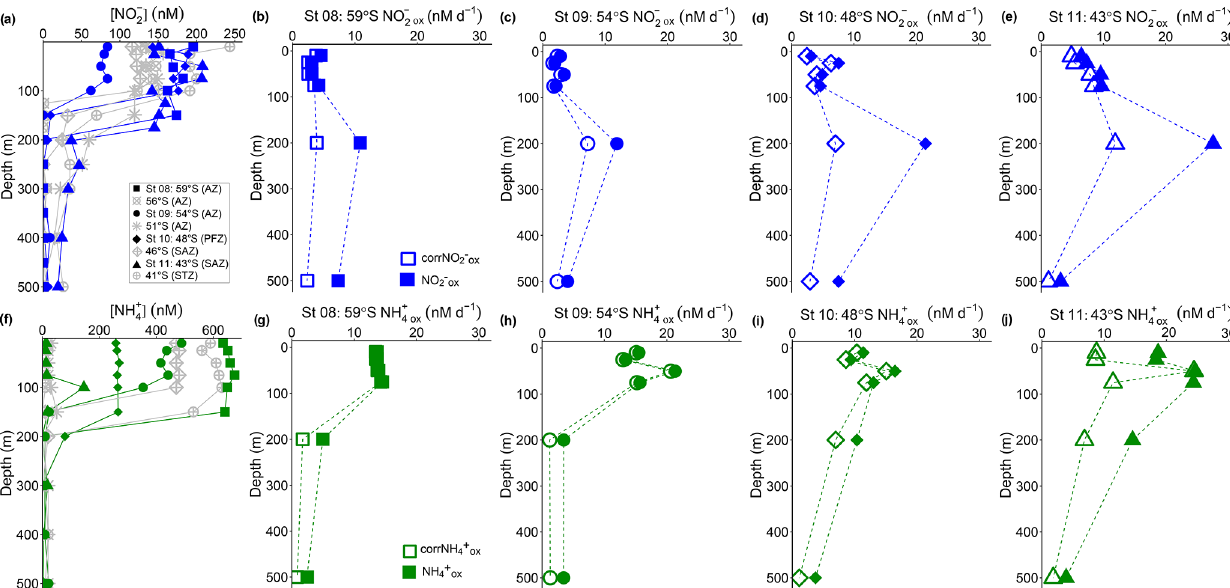
Figure 3. Depth-profile experiments: water column (0–500m) profiles of the concentration of (a) nitrite ([NO − ]) and (f) ammonium 2 oxidation at (b, g) St 08, 59 ◦ S (AZ), (c, h) St 09, 54 ◦ S (AZ), (d, i) St 10, 48 ◦ S (PFZ), and (e, j) St ([NH + ]), and rates of NO − and NH + 4 2 4 11, 43 ◦ S (SAZ). In (a, f) , the blue and green symbols indicate the stations at which oxidation rates were measured, while the grey symbols show data from the stations where no experiments were conducted. In (b–e) and (g–j) , open symbols show the oxidation rates revised for possible stimulation due to 15 N-tracer additions (corrNO − and corrNH + ; Eq. 4), and closed symbols show the uncorrected rates (Eq. 1). 2 ox 4 ox Error bars indicate the range of measured values. Where error bars are not visible, they are smaller than the data markers. The dashed lines connecting the data points are included only to guide the eye and should not be taken to imply interpolation with